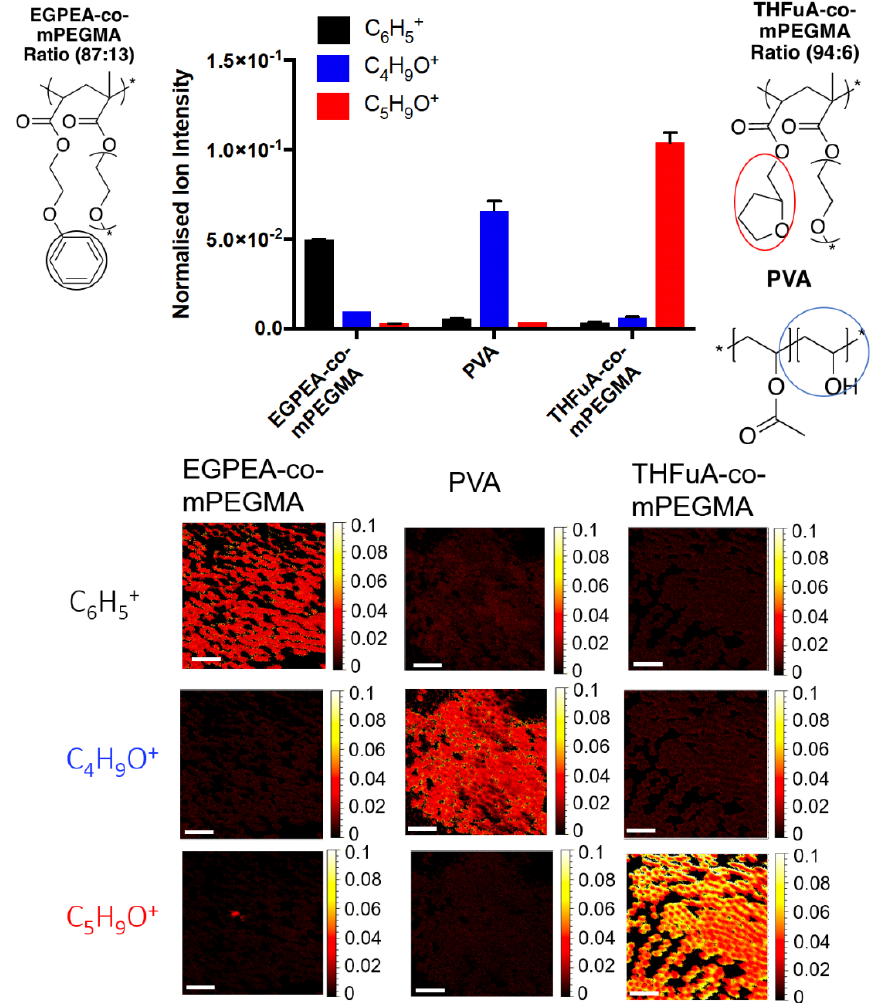
Figure 5. ToF-SIMS data showing intensities and chemical map images of three key ions associated to three surfactant structures (C 6 H 5+ –EGPEA-co-mPEGMA, C 4 H 9 O + –PVA and C 5 H 9 O + –THFuA-co-mPEGMA) where ions from the structures are circled in black, blue and red, respectively. Molar ratios of surfmers (hit material:mPEGMA) that have been included in the formulations were EGPEA-co-mPEGMA (87:13) and THFuA-co-mPEGMA (94:6). Particles containing surfmer were prepared using a dispersed phase containing 5% w / v PDLLA in ethyl acetate and a 0.1% w / v surfmer concentration. Emulsions were formed in a 0.1% w / v PVA concentration. Particles prepared without surfmer were prepared using a dispersed phase containing 5% w / v PDLLA in ethyl acetate. Emulsions were formed in a 2% w / v PVA concentration. Ion intensities have been normalised against total ion intensity. Error bars equal ± 1 SD unit, n = 3. Chemical map images are shown from a normalised intensity of 0 (black) to a normalised intensity of 0.1 (white). Scale bars on chemical images represent 100 µm.